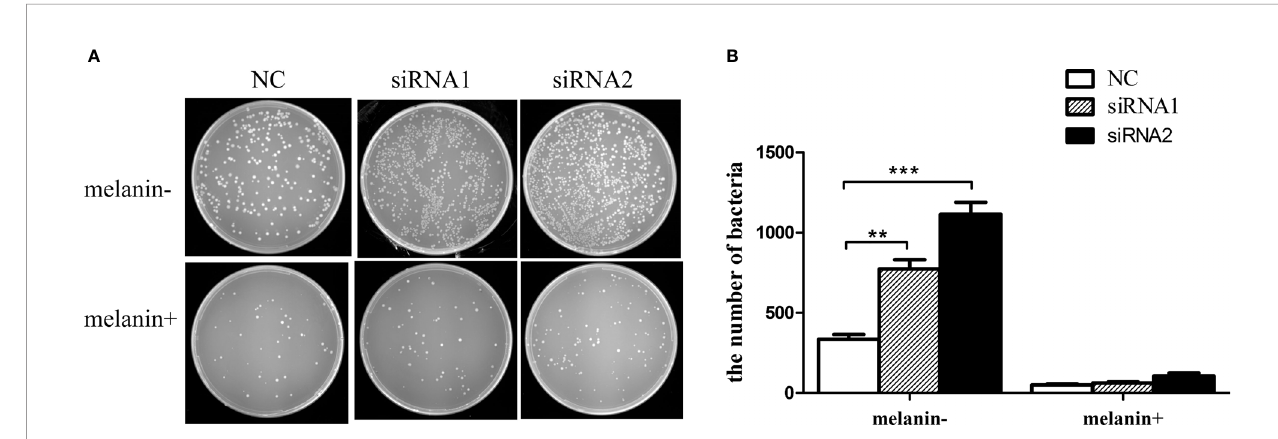
FIGURE 10 | Antibacterial activity of melanin oxidation products from P. penguin samples. (A) Photographs showed the number of E. coli after Mitf silencing and adding melanin oxidation products. (B) Histogram showed the number of E. coli after Mitf silencing and adding melanin oxidation products. Each value was shown as mean ± SD ( N = 5; * P < 0.05; ** P <